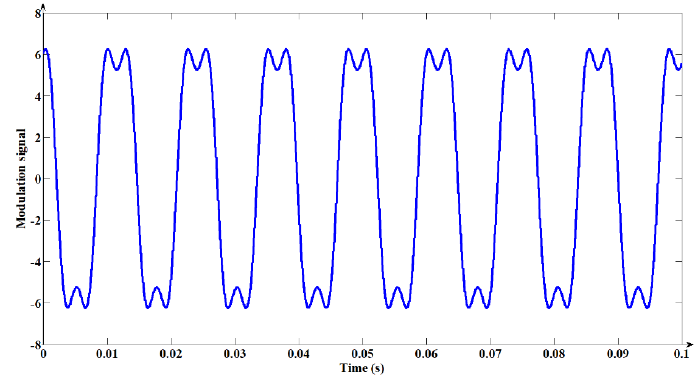
Figure 41. Depenbrock’s PWM-1 phase waveform.